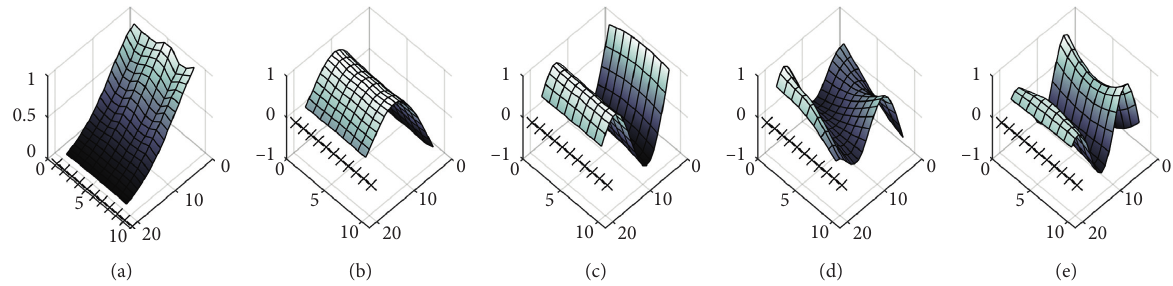
Figure 10: The first five experimental mode shapes acquired structural state M#2: (a) mode 1, (b) mode 2, (c) mode 3, (d) mode 4, and (e) mode